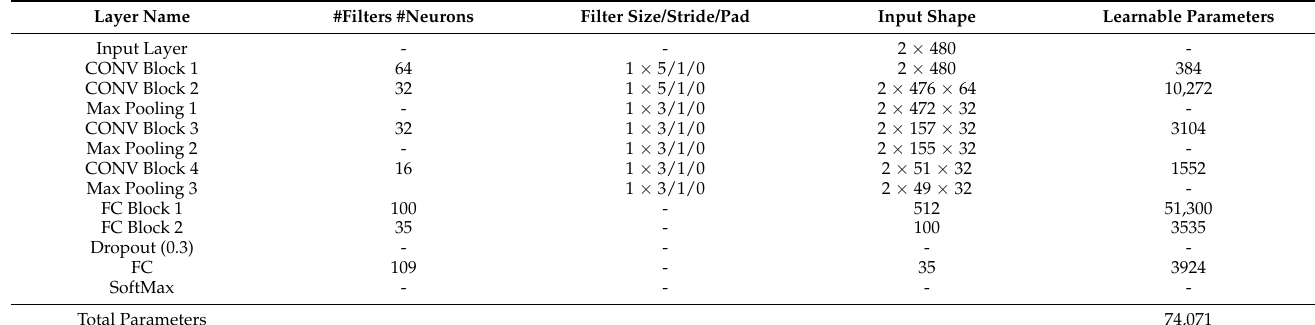
Table 3. CNN Model Network